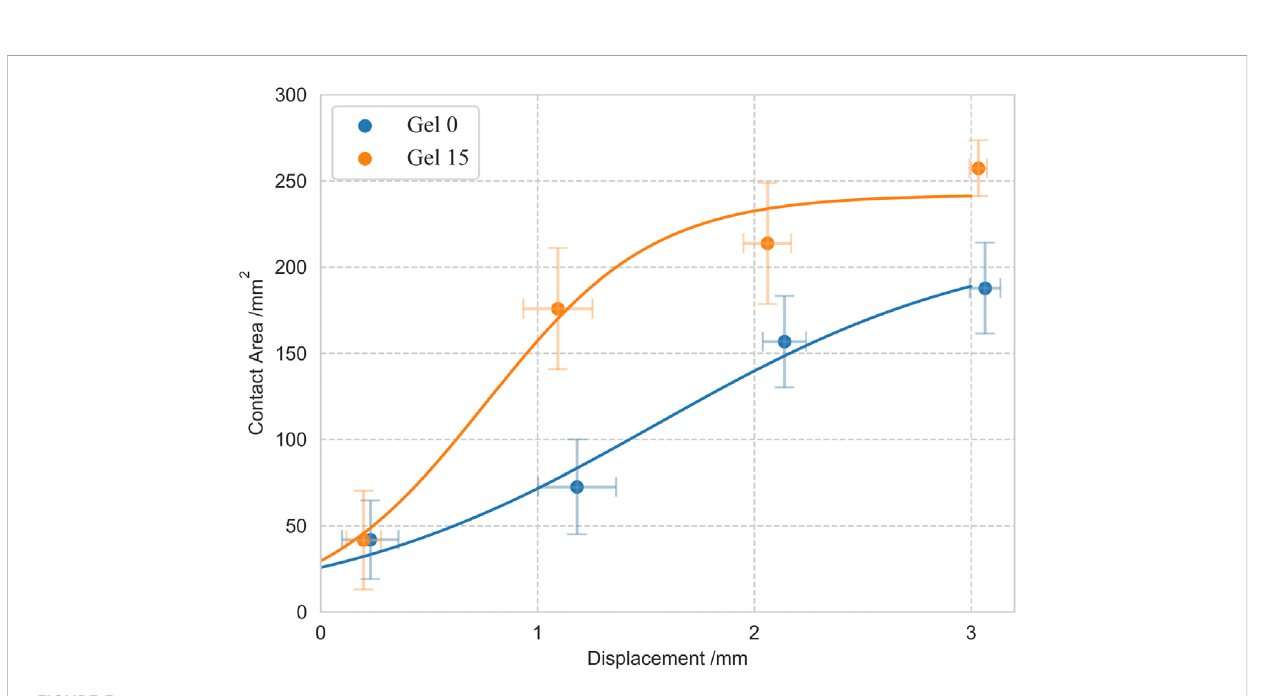
Contact area measurement results and regression